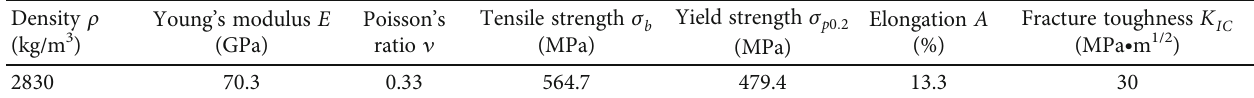
Table 2: Mechanical properties of 7050-T7451 aluminum alloy.